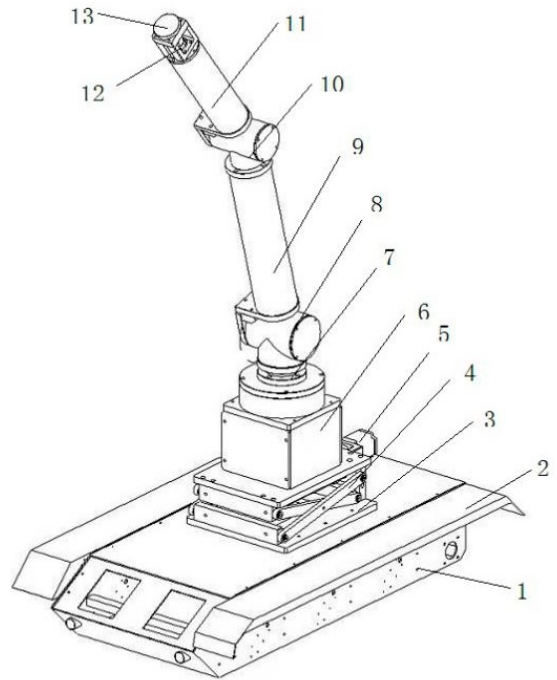
Figure 1. Manipulator structural drawing of picking robot (1: picking robot platform; 2: platform; 3: robot base; 4: lift platform; 5: servo motor; 6: robot lumbar; 7: lumbar rotating shaft; 8: main arm joint; 9: main arm; 10: small arm joint; 11: small arm; 12: rotating shaft; 13: grasp hand installation seat).